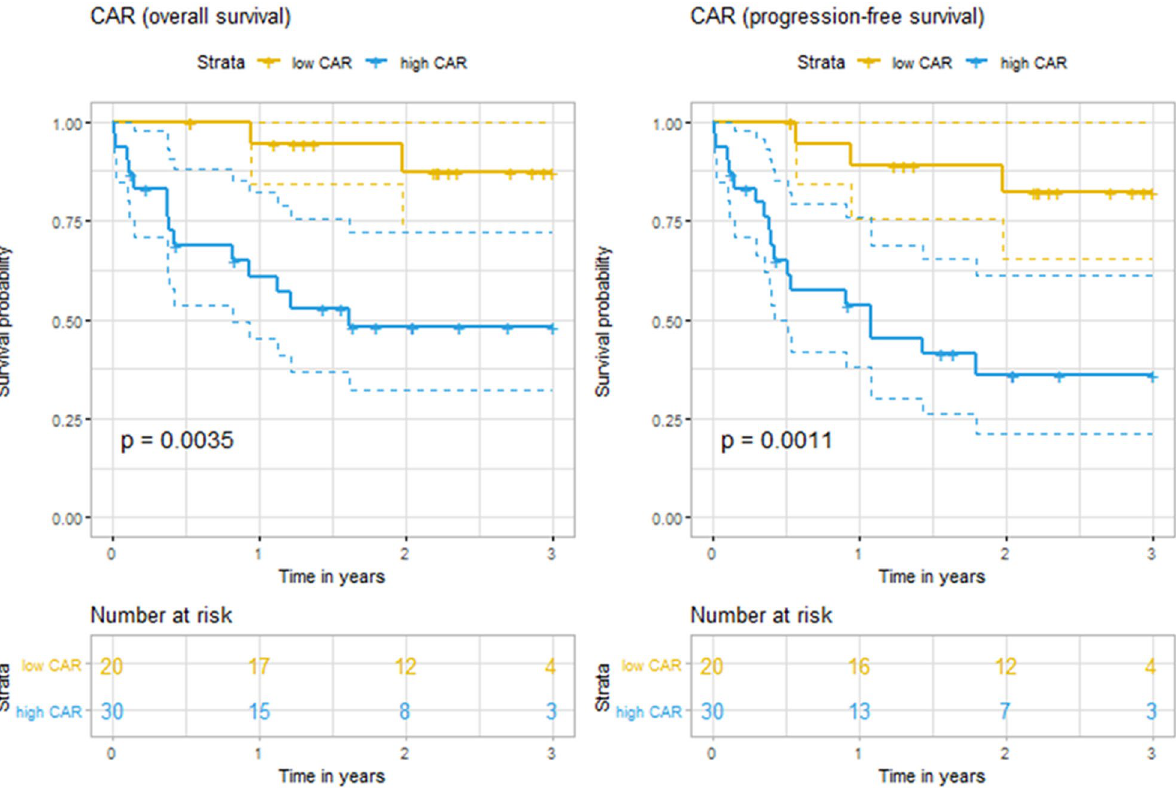
Figure 2. Kaplan–Meier curves for overall survival and progression-free survival according to the C-reactive protein-to-albumin ratio (CAR) at the diagnosis of diffuse large B-cell lymphoma in the validation